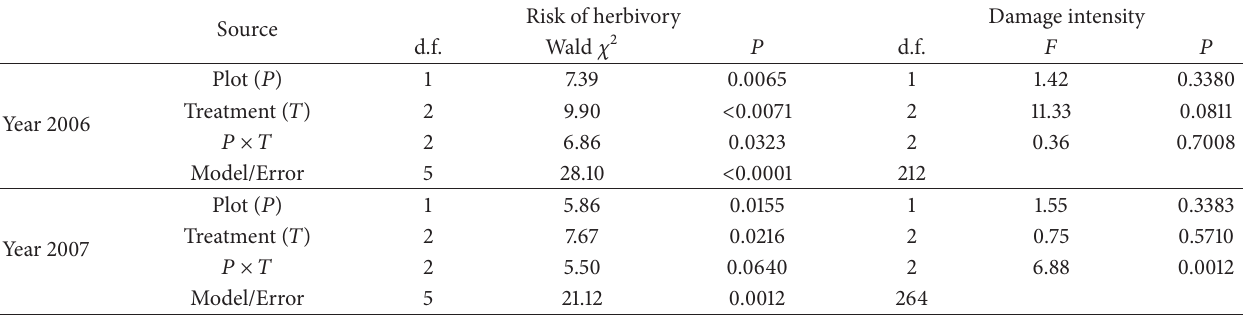
Table 2: Summary of the nominal logistic model for risk of herbivory (proportion of plants that suffered herbivory by ungulates) and two- way ANOVA for damage intensity (proportion of shoots consumed by ungulates in attacked plants) suffered by Ulex parviflorus seedlings in the years 2006 and 2007 (one- and two-year-old plants, resp.). Treatments are no intervention, partial cut plus lopping, and salvage logging.